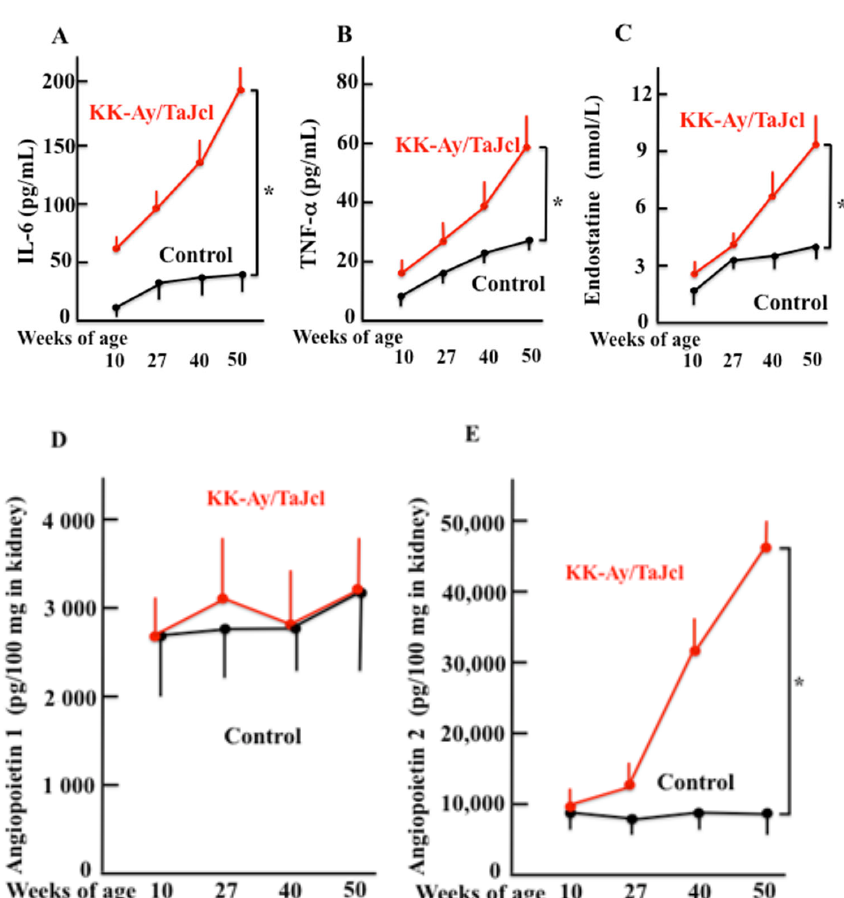
Figure 5. Effect of aging on the plasma of IL-6 ( A ), TNF- α ( B ), and endostatine ( C ) levels; and the kidney levels of angiopoietin 1 ( D ) and 2 ( E ) in KK-Ay/TaJcl mice. Plasma levels of TNF- α , IL-6, and IL-10, and the kidney levels of angiopoietin 1 and 2 in mice were measured with ELISA. Values are expressed as the mean ± SD derived from five animals. * p < 0.05. Control: C57BL/6j mice.